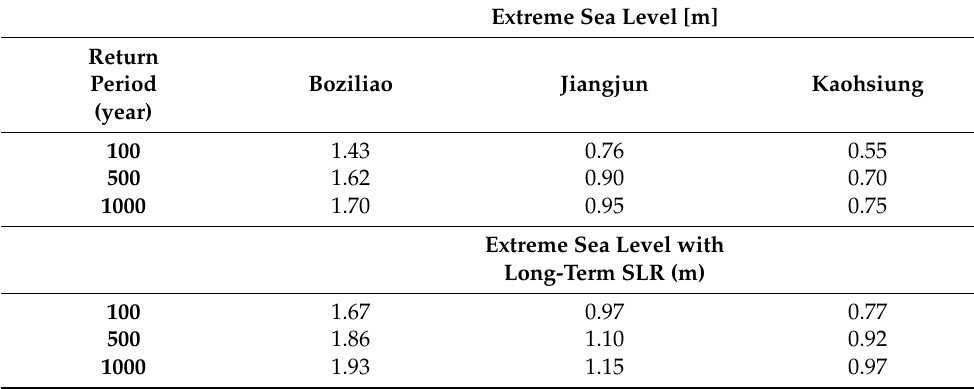
Table 4. The estimation of extreme sea level of tide-gauge stations.